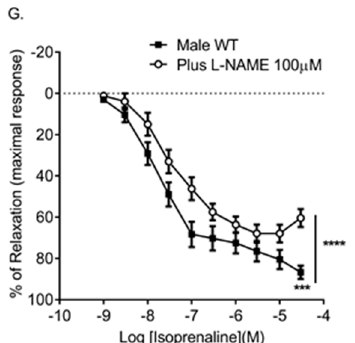
Figure 4. Effects of genetic reduction or pharmacological inhibition of Cx43 on pulmonary vascular relaxation responses. Male ( A ) and female ( B ) Cx43 heterozygous ( Cx43 +/ − ) mice show reduced relaxation in response to MCh. Pre-incubation with 37,43 Gap27 also reduced the relaxation response in male ( C ) and female ( D ) mice. MCh-induced relaxation was ablated in the presence of L -NAME ( E ). 37,43 Gap27 partially inhibited isoprenaline-induced relaxation in IPAs from male mice ( F ) as did L -NAME ( G ). Global differences in concentration response curves were compared by two-way ANOVA. Changes in logarithm of median effective concentration (Log EC 50 ) and maximal relaxation responses (R max ) between two different groups were analyzed by using the Student’s t -test. Data are shown as mean ± S.E.M. * p < 0.05, ** p < 0.01, *** p < 0.001, **** p < 0.0001, n = 5–6 per group. Statistical symbols shown on the right hand side of graphs indicate global shifts in the concentration response curves. Statistical symbols underneath curves indicate changes in maximal relaxation (R max ) values. Table 2. Log EC 50 (logarithm of median effective concentration) and R max (maximal relaxation) values for MCh-induced or isoprenaline-induced relaxation.